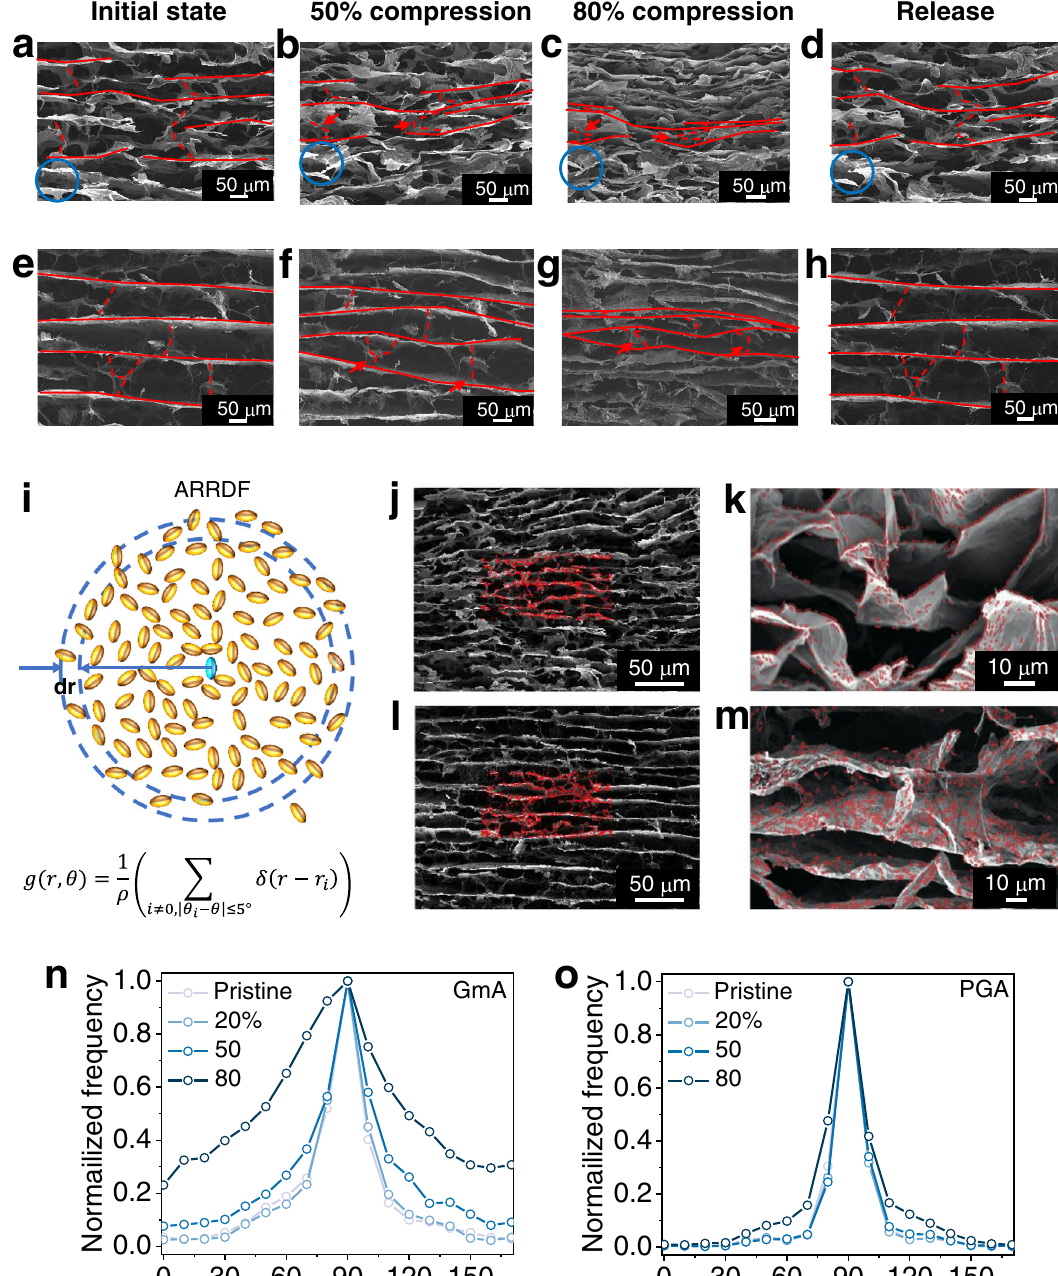
Fig. 4 | Strengthen mechanism analysis of SEM observation and ARRDF. a – d SEM images of PGA under different compression state, a 0%, b 50%, c 80%, d release. Arrows in b mark the local instability parts. Arrows in c mark the extreme bending parts. Circles points out the fracture process of the graphene wall. e – h SEM images of GmA under different compression state, e 0%, f 50%, g 80%, h release.Arrowsin f and g markthestablebulkdeformationprocess. i Thescheme and functions of angle-resolved radial distribution function (ARRDF) describehow